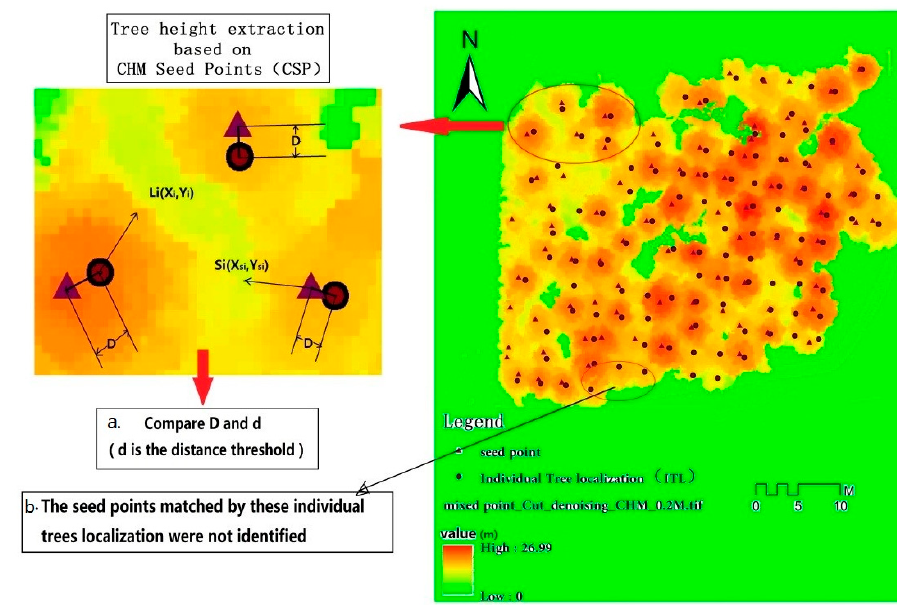
Figure 7. The distance threshold method in CSP: ( a ) The projection distance between each seed point and the nearest ITL point as D ; and ( b ) some seed points matched by ITL were not identified.